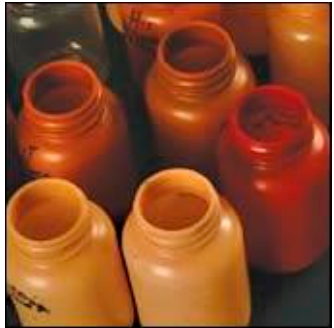
Figure 14. Injection-blow moulded bottles made from cotton/PLA based composites [115].